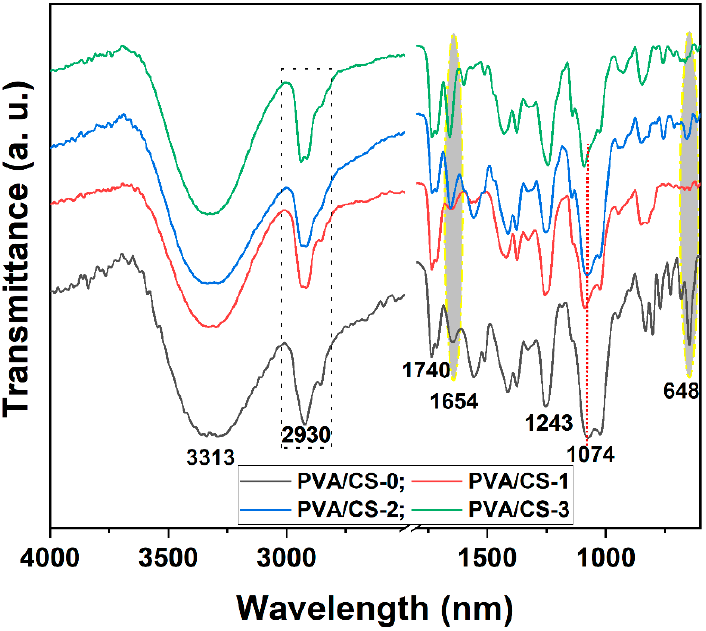
Figure 2. Fourier-transform infrared (FTIR) spectra for PVA/CS composites.